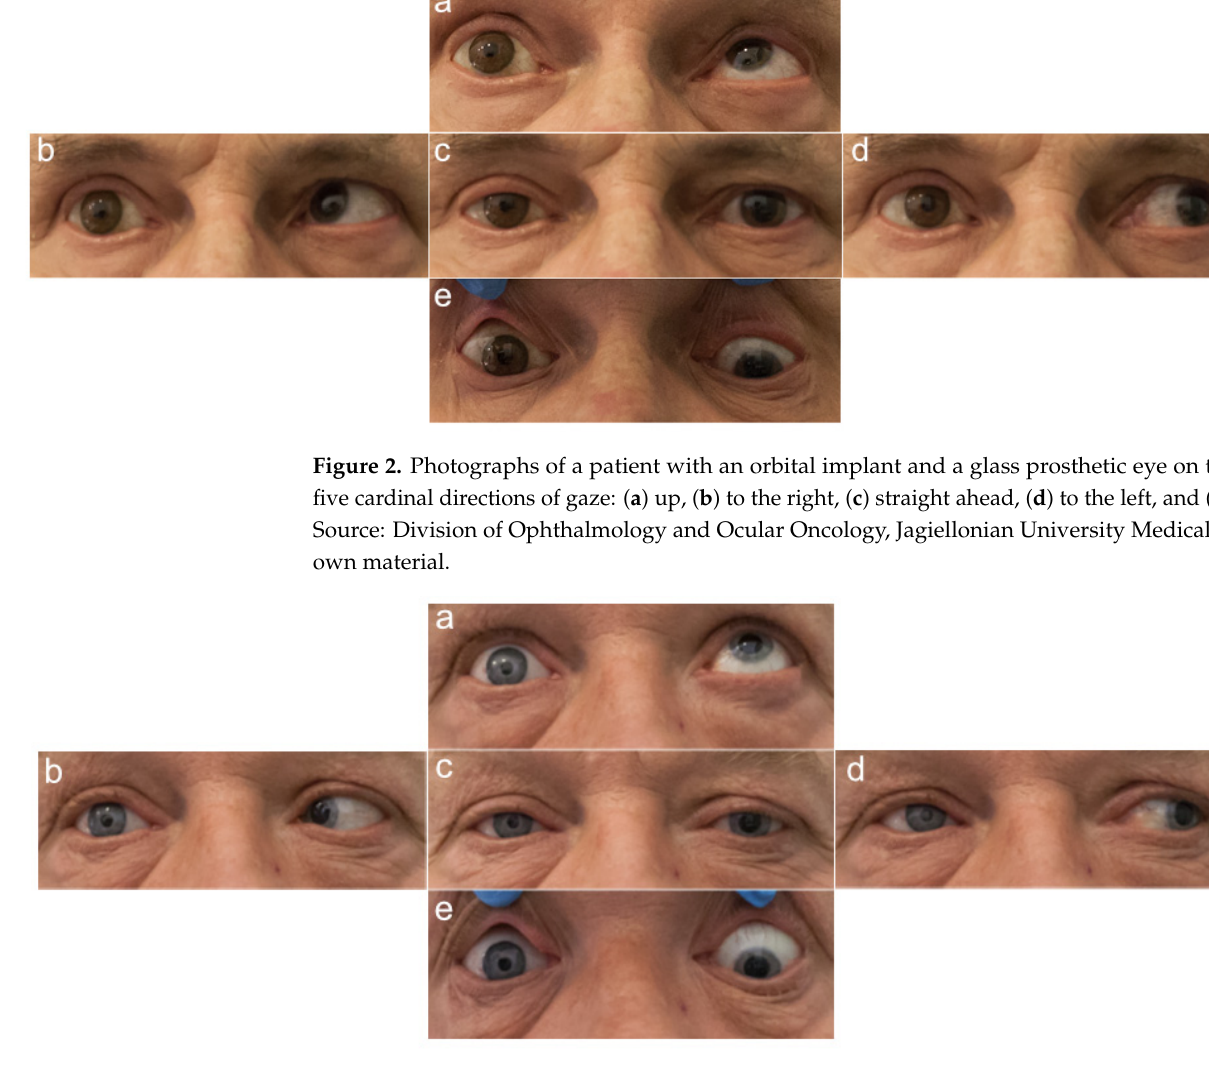
Figure 3. Photographs of a patient with an orbital implant and an acrylic prosthetic eye on the right. Five cardinal directions of gaze: ( a ) up, ( b ) to the right, ( c ) straight ahead, ( d ) to the left, and ( e ) down. Source: Division of Ophthalmology and Ocular Oncology, Jagiellonian University Medical College; own material.